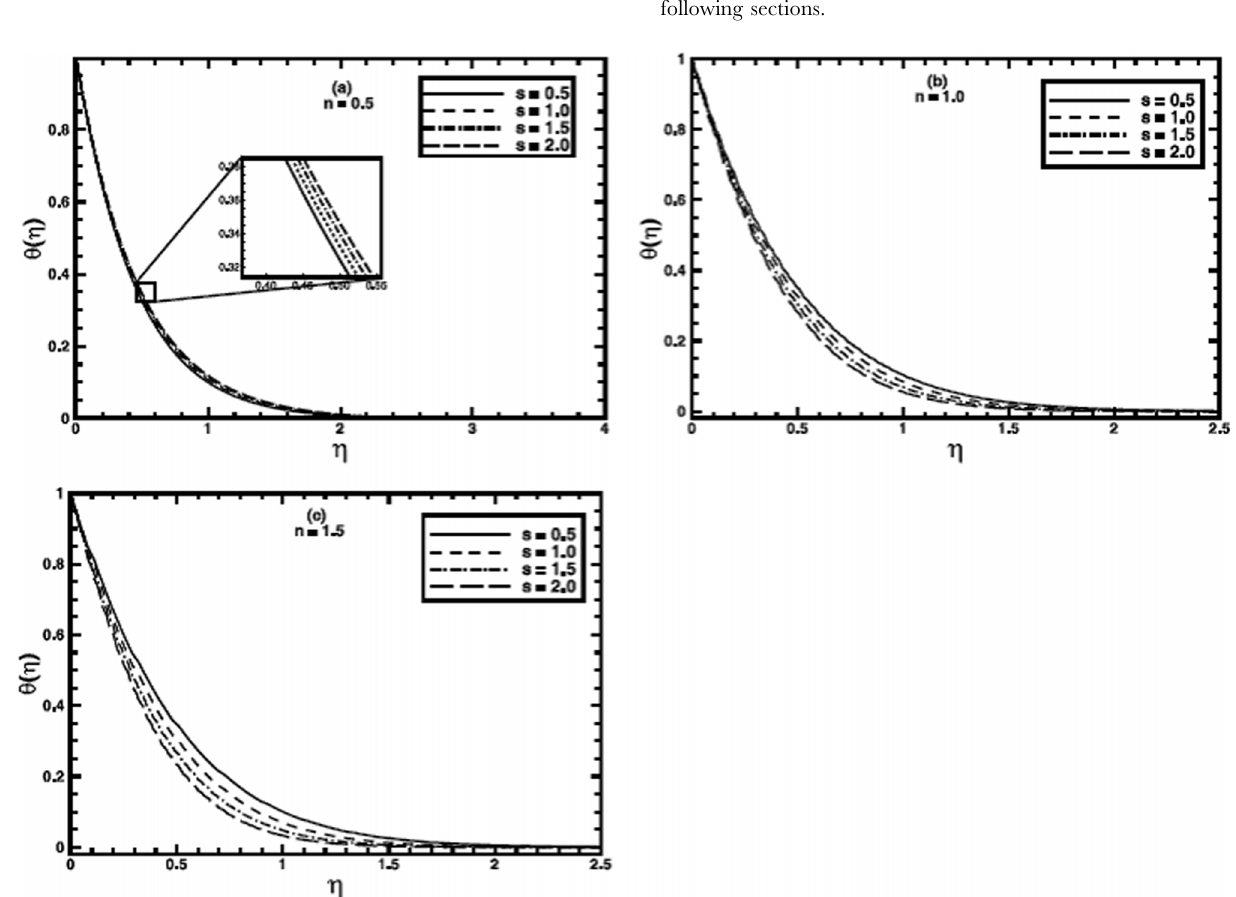
Figure 3. The temperature profile h g ð Þ in the PST case for different values of the stretching parameter s when m ~ 1 : 5 , Pr ~ 3 and A ~ 1 are fixed.